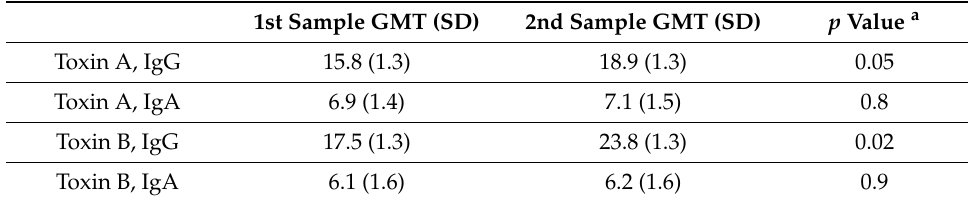
Table 3. The geometric mean titers of serum IgG and IgA antibodies level against toxin A and B of Clostridium difficile obtained from CDI patients 14 days apart.